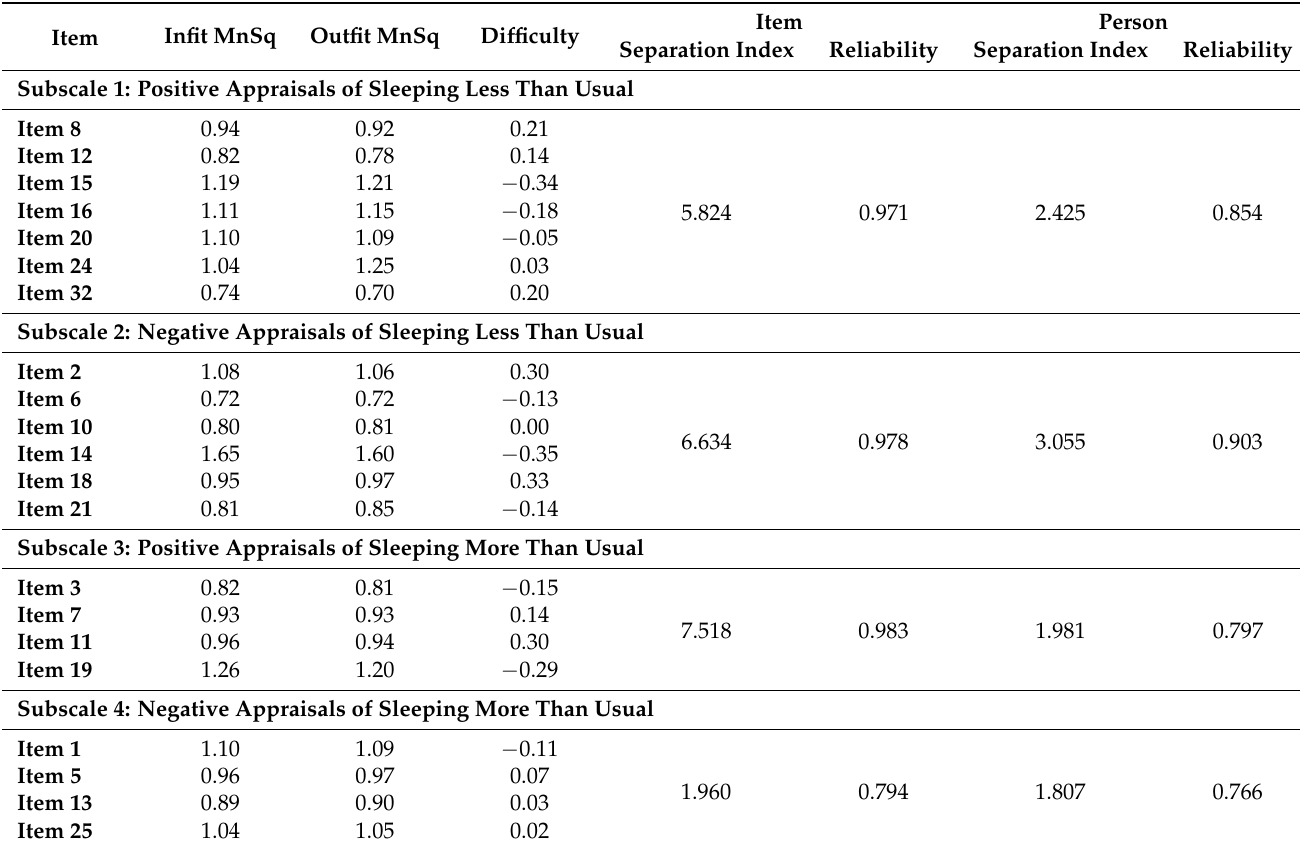
Table 4. Item fits and difficulties of the Korean version of the PANSAM scale through the Rasch